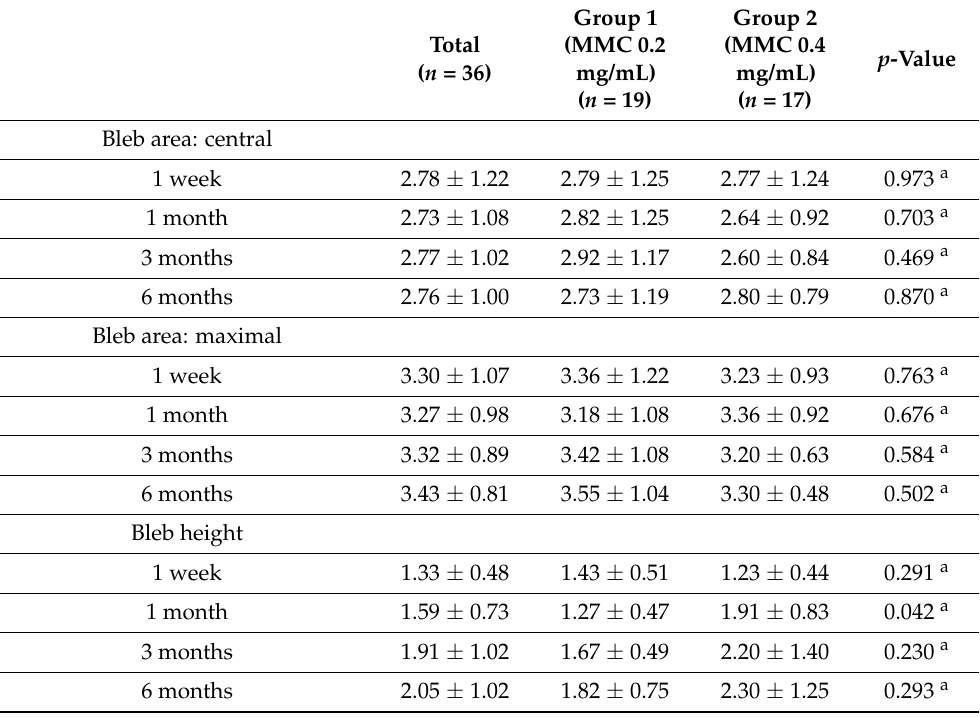
Table 4. Bleb morphology during follow-up